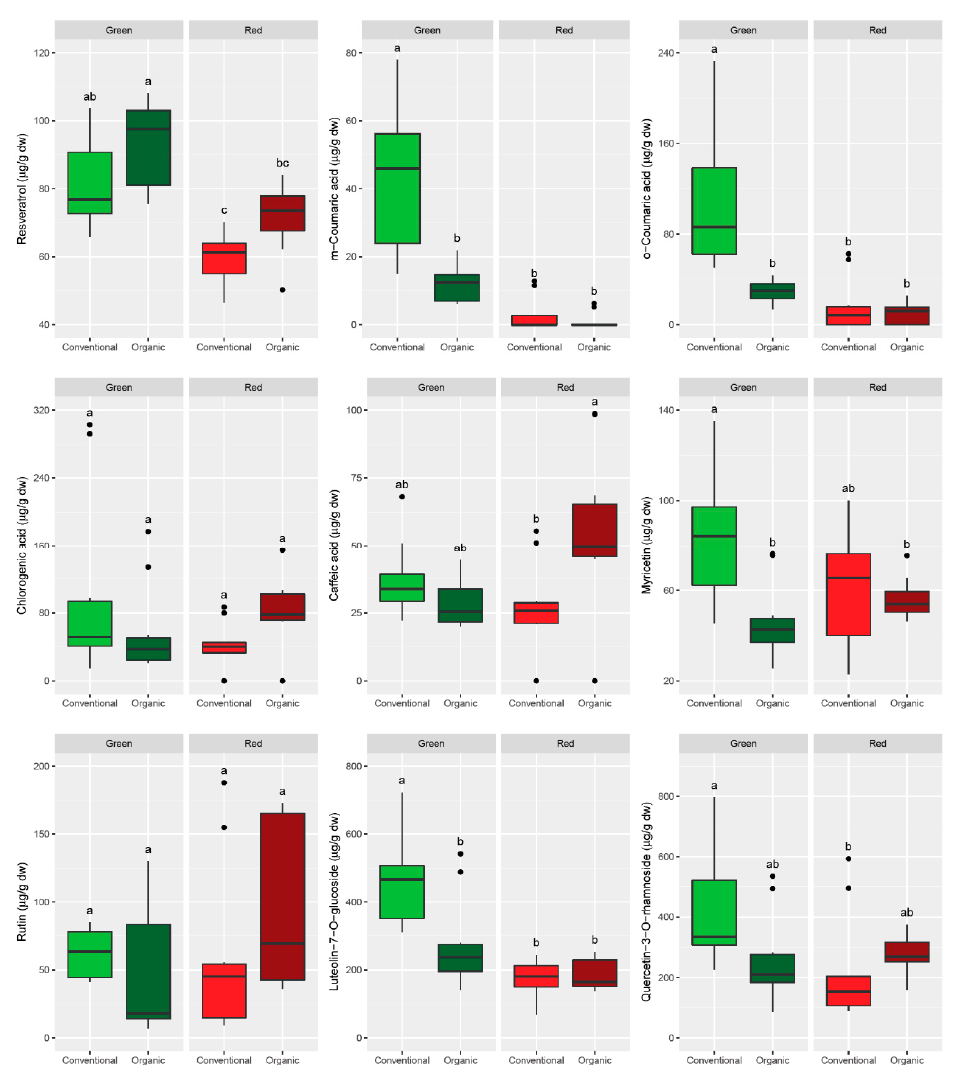
Figure 1. Individual phenolic compounds quantified (in µg g − 1 dw), by High-Performance Liquid Chromatography-Diode-Array Detector (HPLC-DAD), in sweet pepper samples according to the maturation stage (green or red peppers) and agronomic production system (conventional or organic systems). Box bars represent the values that are within the 1st and 3rd quartiles and the horizontal line represents the 2nd quartile (median). Vertical lines from the middle of the top and bottom edges of each box represent the whiskers. Dot points represent minimum or maximum values that fall outside the whisker range (extreme values or outliers). Different lower case letters mean significant statistical differences ( p -value < 0.05) among maturation–production levels.